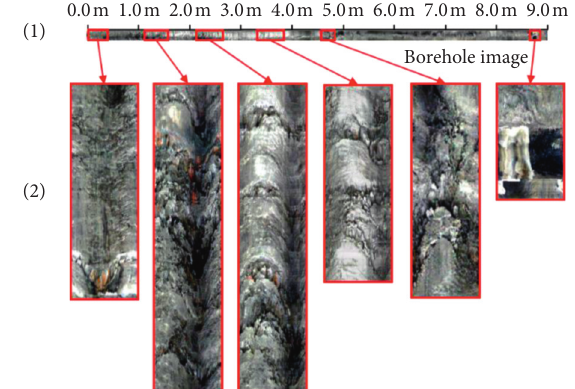
Figure 12: Borehole imaging of borehole #4 at station #2 under the influence of longwall retreatment: (1) the 2D view of the borehole from 0 to 360 ° ; (2) the zoomed-in views of selected